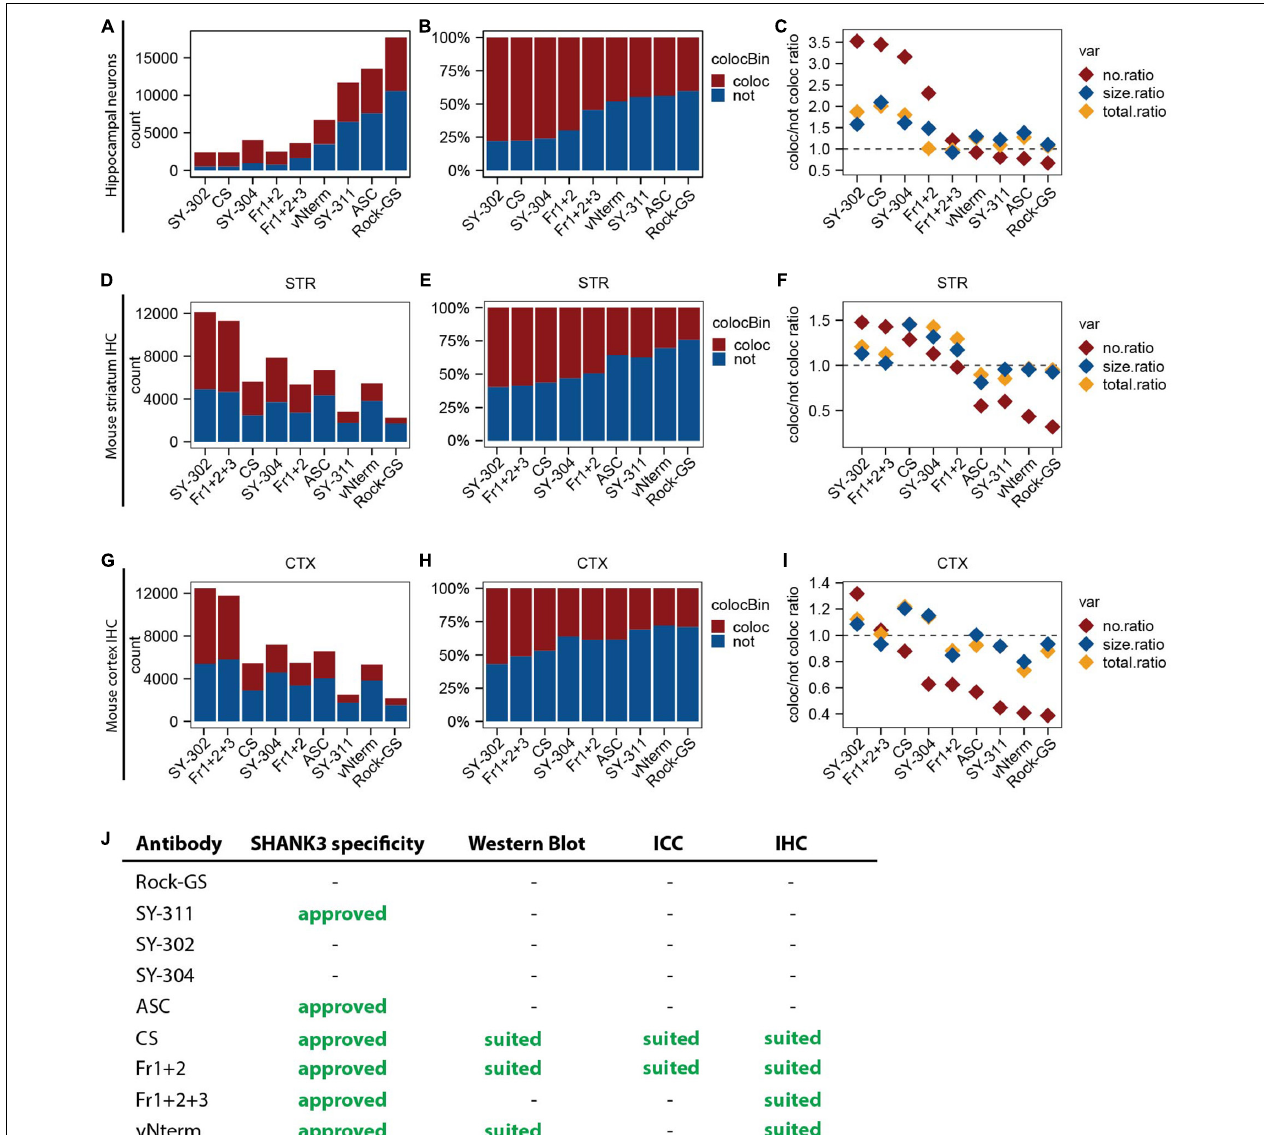
FIGURE 7 | Summary of the results of the SHANK3 antibody validation. (A) Total count of all SHANK3 puncta detected in all primary hippocampal neurons. Co-localizing SHANK3 puncta with a pre-synaptic marker are depicted in red, not co-localizing ones in blue. (B) Relative count of all SHANK3 puncta detected in all primary hippocampal neurons in percentage. Co-localizing ones with a pre-synaptic marker are depicted in red, not co-localizing ones in blue. (C) Number (red), size (blue), and total intensity (yellow) of SHANK3 puncta in primary hippocampal neurons are depicted. For each of the variables the ratio between co-localizing and not co-localizing puncta was calculated. (D) Total count of all SHANK3 puncta detected in all WT striatal stainings. Co-localizing SHANK3 puncta with a pre-synaptic marker are depicted in red, not co-localizing ones in blue. (E) Relative count of all SHANK3 puncta detected in all WT striatal stainings. Co-localizing ones with a pre-synaptic marker are depicted in red, not co-localizing ones in blue. (F) Number (red), size (blue), and total intensity (yellow) of SHANK3 puncta in WT striatal stainings are depicted. For each of the variables the ratio between co-localizing and not co-localizing puncta was calculated. (G) Total count of all SHANK3 puncta detected in all WT cortical stainings. Co-localizing SHANK3 puncta with a pre-synaptic marker are depicted in red, not co-localizing ones in blue. (H) Relative count of all SHANK3 puncta detected in all WT cortical stainings. Co-localizing ones with a pre-synaptic marker are depicted in red, not co-localizing ones in blue. (I) Number (red), size (blue), and total intensity (yellow) of SHANK3 puncta in WT cortical stainings are depicted. For each of the variables the ratio between co-localizing and not co-localizing puncta was calculated. (J) Overview summarizing the performance of all SHANK3 antibodies tested in this